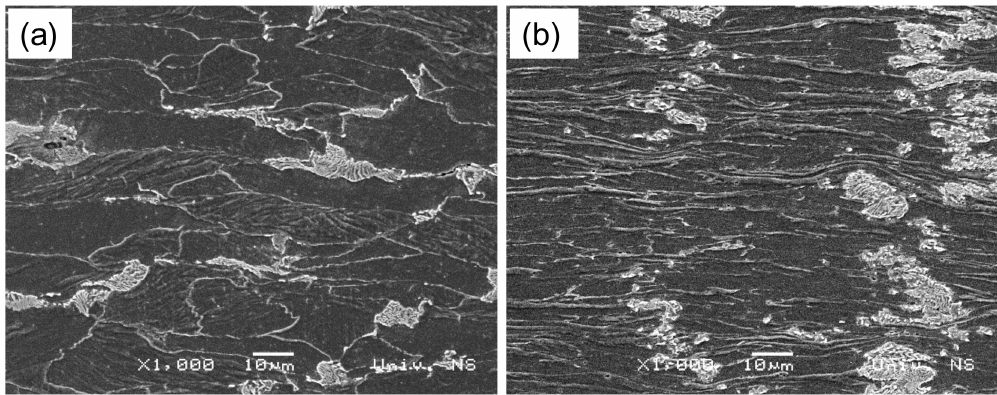
Figure 14. SEM microstructure (1000 × ): ( a ) severe plastic deformation (SPD) process and ( b ) Rastegaev’s